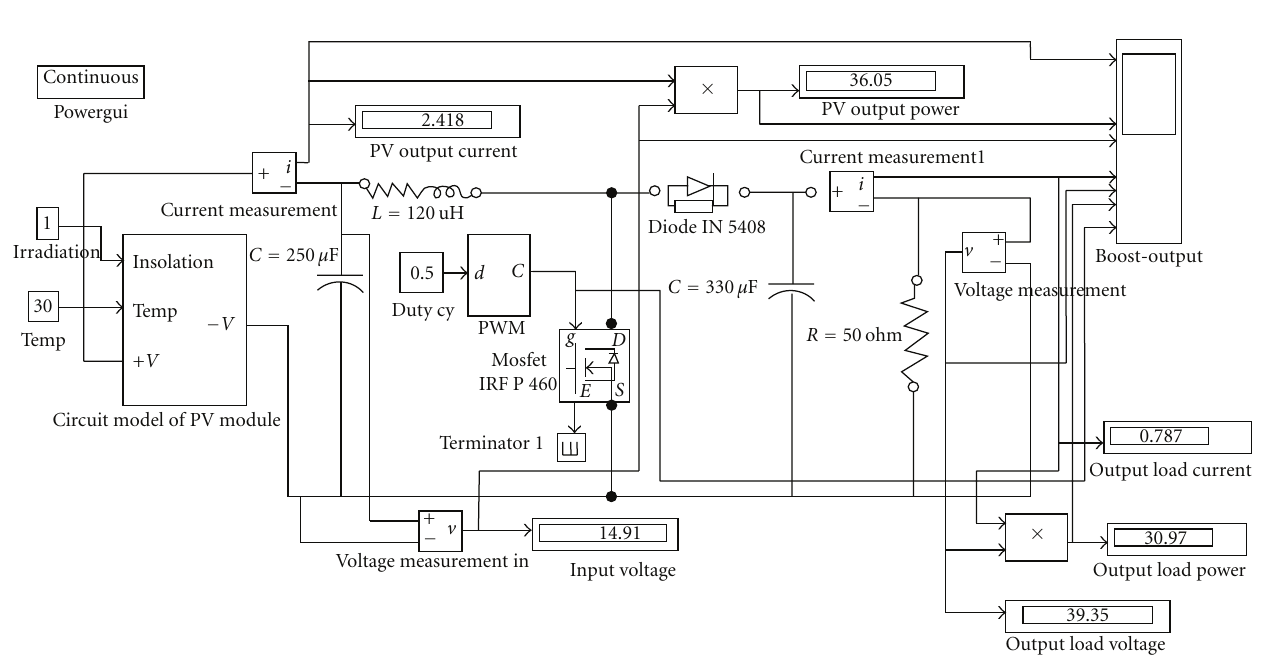
Figure 16: Boost converter circuit with DC supply.